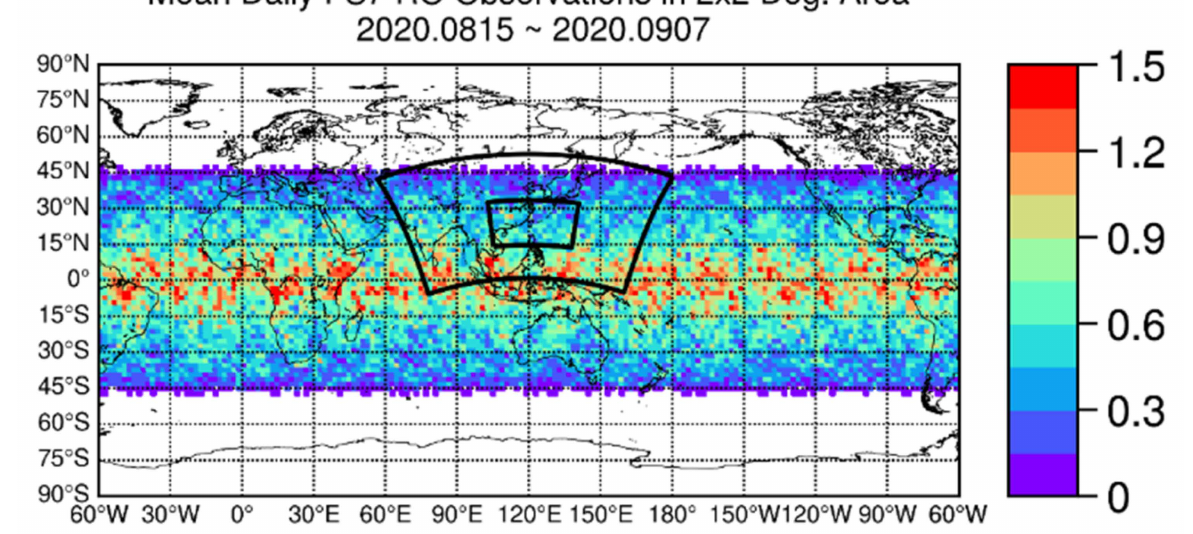
Figure 1. Number of mean daily FS7 RO profiles in 2 × 2 degrees areas from 15 August to 7 September 2020. The black frames show the CWBWRF 15-km (outer) and 3-km (inner) domain coverage, but the 3-km domain is not used in this